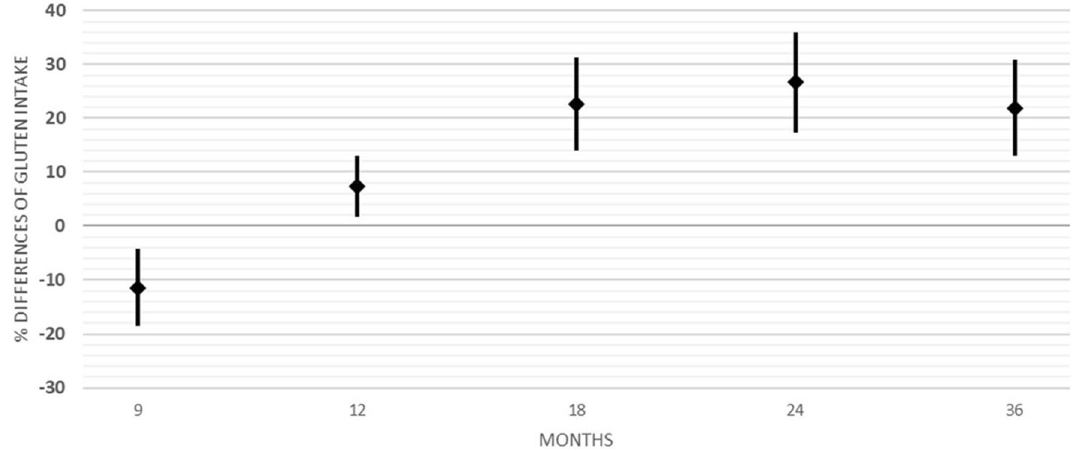
Figure 2. Differences between the means (± 95C.I.) in gluten intake per kg/day between celiac disease (CD) cases and controls (CTRLs) at 9, 12, 18, 24 and 36